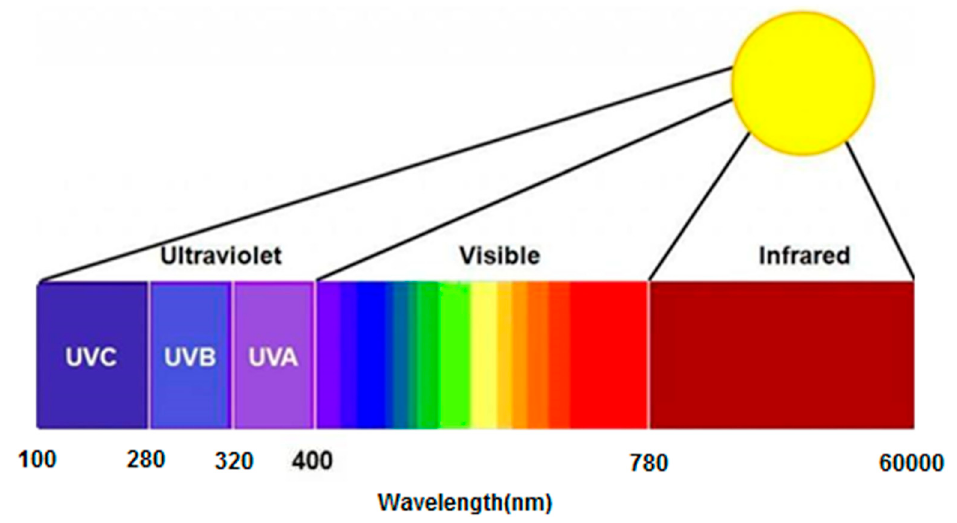
Figure 2. Sun spectrum